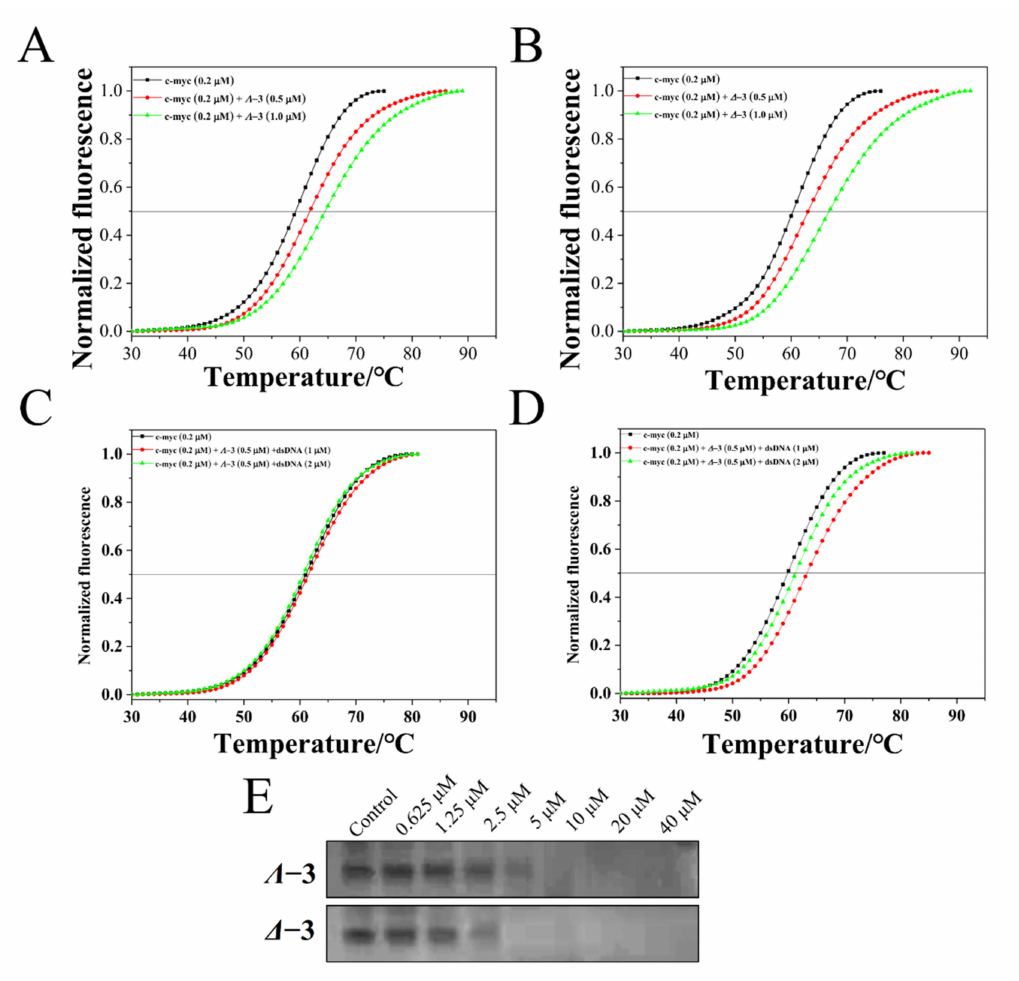
Figure 4. The effect of chiral DPPZ-based Ru(II)complexes on the stability of c-myc G-quadruplex conformation. FRET melting points of c-myc G-quadruplex DNA with different concentrations of Λ − 3 ( A ) and ∆ − 3 ( B ). Competitive FRET melting curves of c-myc (0.2 µ M) with 0.5 µ M of Λ − 3 ( C ) and ∆ − 3 ( D ) and a duplex competitor ds26 (1–2 µ M). ( E ) Effect of complexes Λ − 3 and ∆ − 3 on the PCR-stop assay with c-myc G-quadruplex